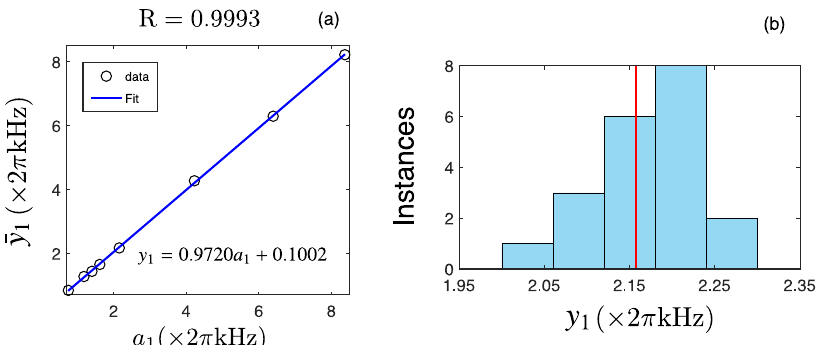
obtained from the NN with respect to each target. In addition, 1